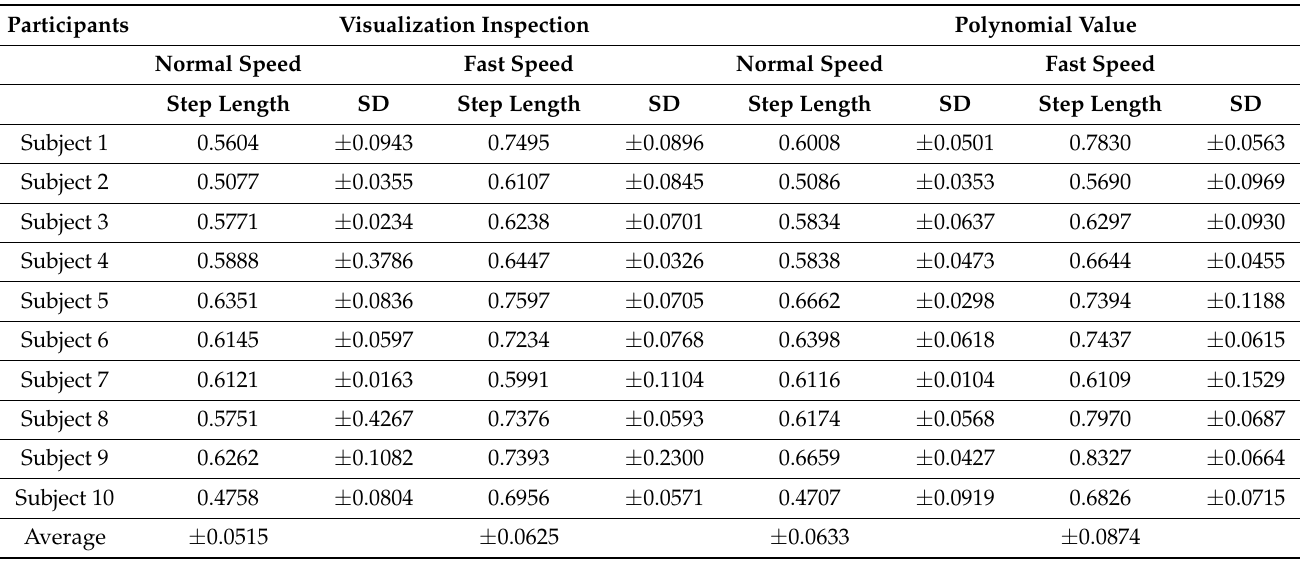
Table 3. The standard deviation (SD) of step length in comparison with the quadratic polynomial curve fitting value and the visually detected